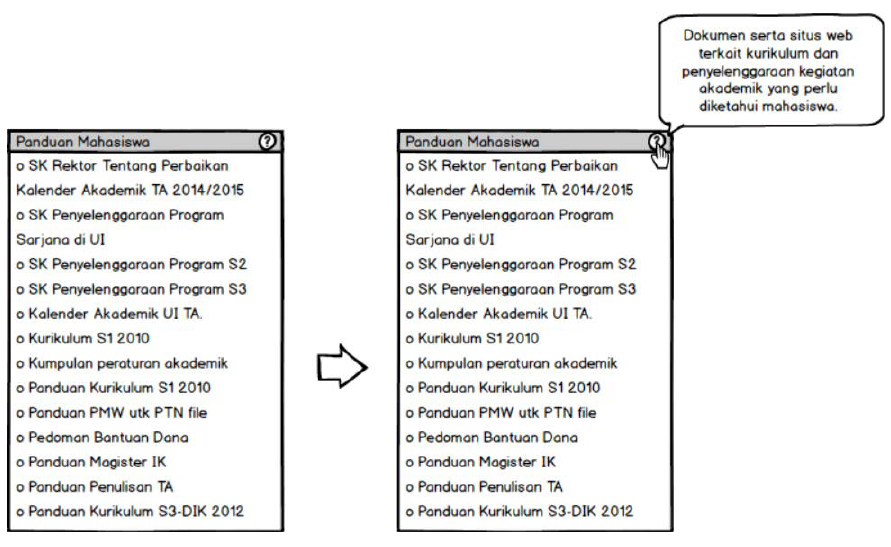
Figure 2. A sample of wireframe that created using Balsamiq Interface Design for e-Learning